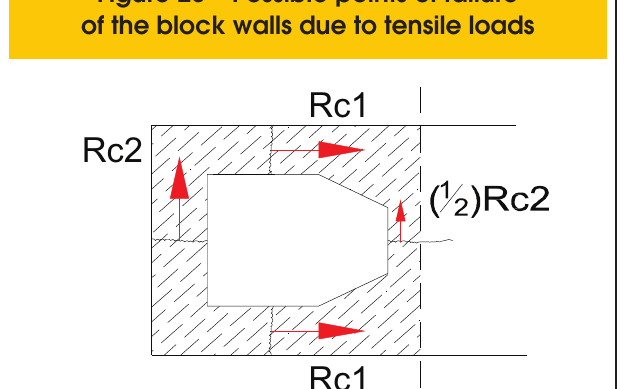
Figure 20 – Possible points of failure of the block walls due to tensile loads